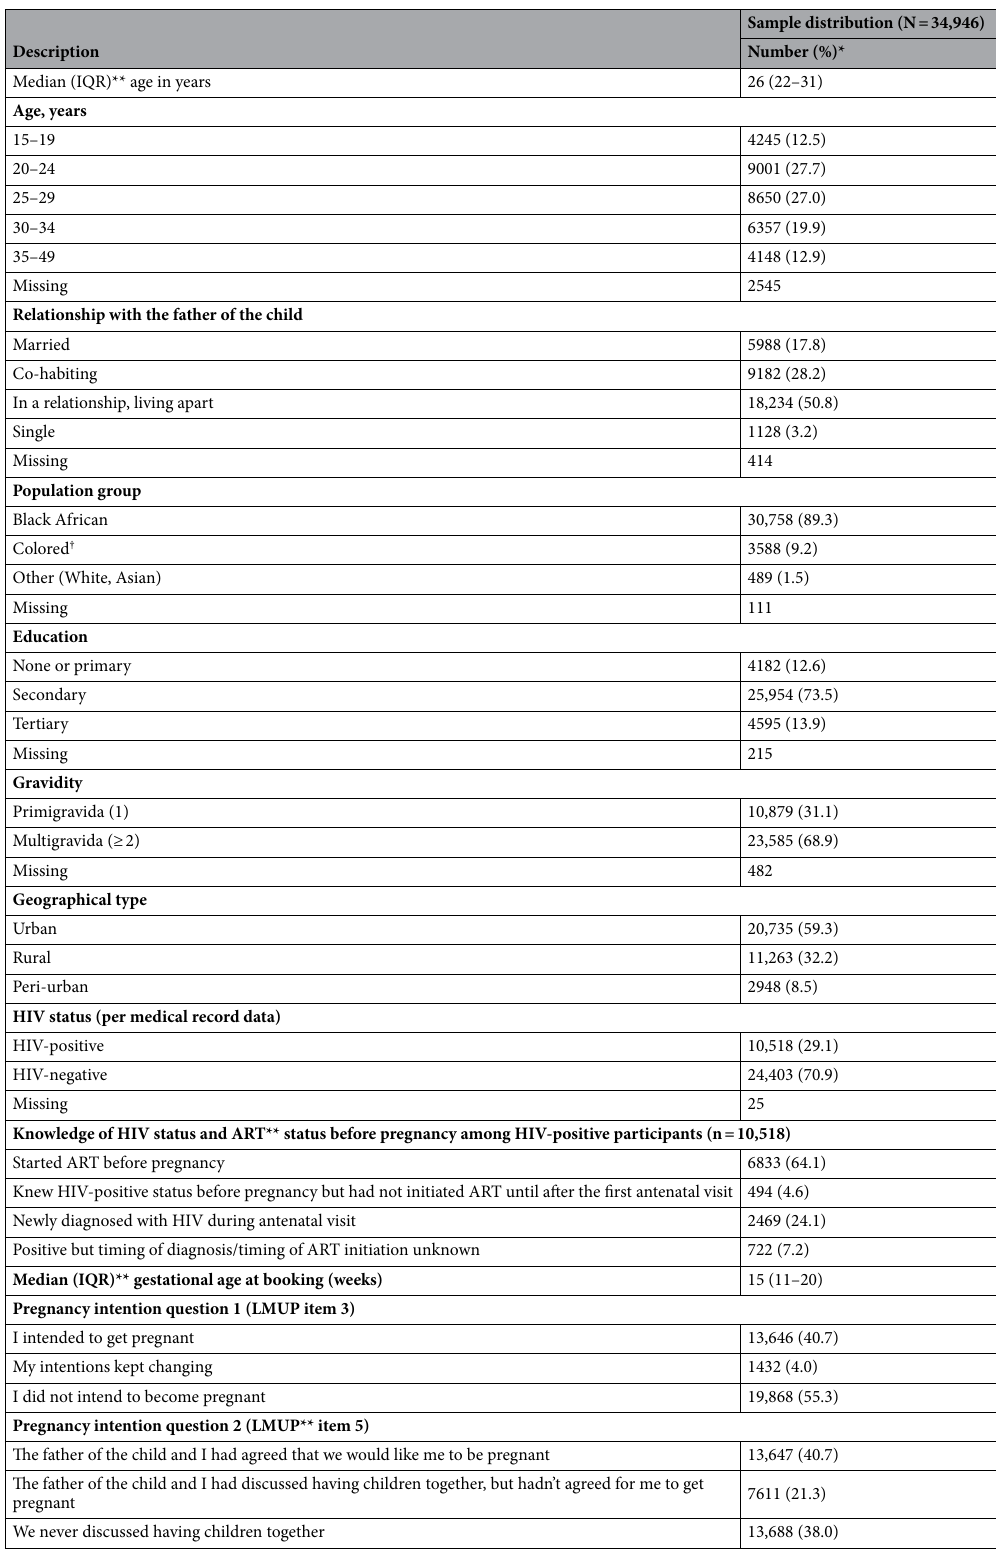
Table 2. Sociodemographic and clinical characteristics of participants who responded to the pregnancy intention questions in the 2019 antenatal HIV Sentinel Survey, South Africa. † Colored refers to a multiracial ethnic group. *Weighted percentages. Missing data excluded from the denominator when calculating percentages. **ART, antiretroviral therapy; IQR, interquartile range; LMUP, London Measure of Unplanned